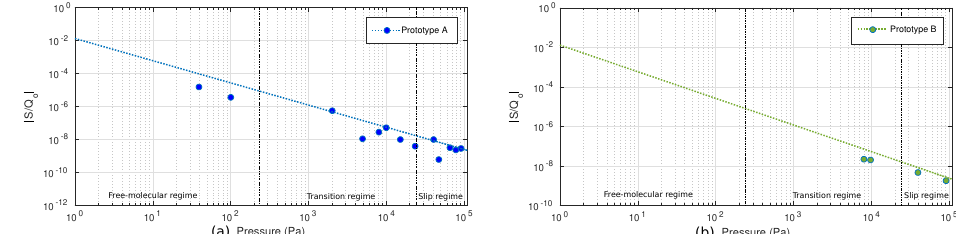
Figure 8. Sensitivity relative to ambient pressure as a reference point. ( a ) Prototype A sensitivity, ( b ) Prototype B